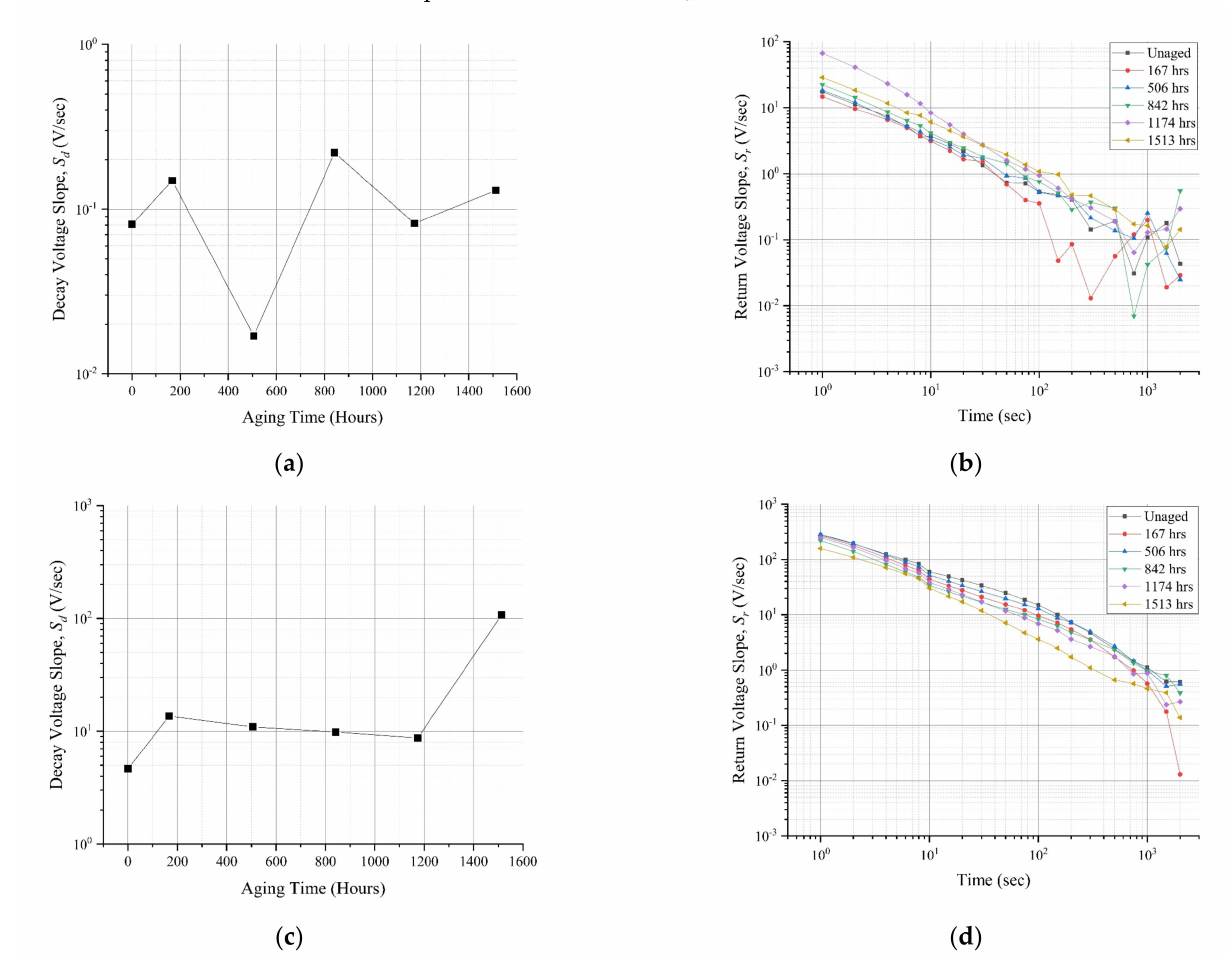
Figure 6. EVR measurement, EPR insulation: ( a ) S d vs. different thermal aging periods, ( b ) S r vs. discharging time for different thermal aging periods, CSPE jacket, ( c ) S d vs. different thermal aging periods, and ( d ) S r vs. discharging time for different thermal aging